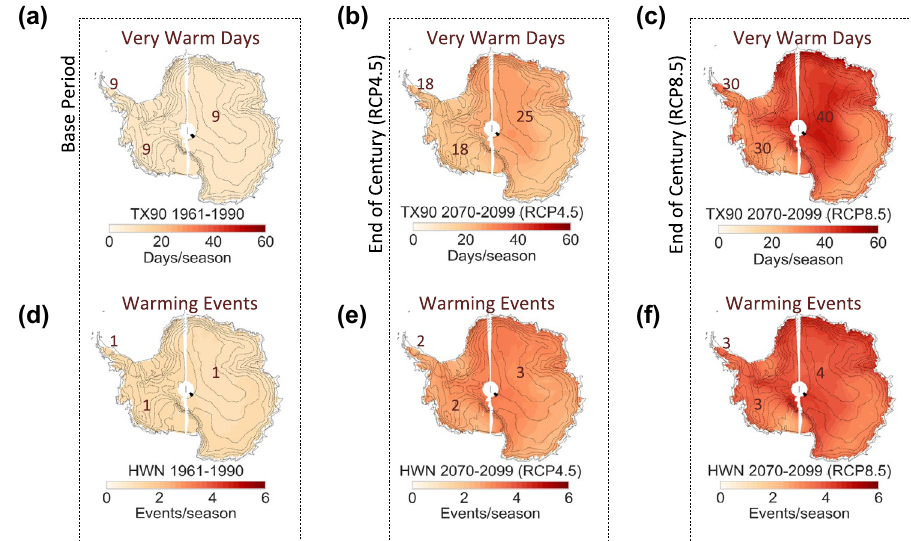
Figure 2. Summer Warming Events will become more frequent. Multi model mean (MMM) of summer HW metrics computed from 15 CMIP5 GCMs over the base period 1961–1990 (1st column), over the period 2070– 2099 under the RCP4.5 scenario (2nd column), and over the period 2070–2099 under the RCP8.5 scenario (3rd column). ( a–c ) Number of very warm days per season (TX90); ( d–f ) number of HWs per season (HWN). Plots were generated by using Python’s Matplotlib Library 44 .